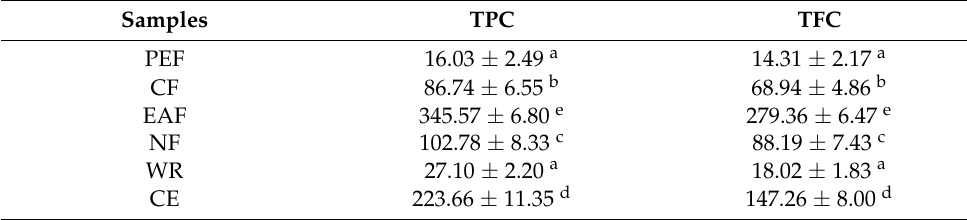
Table 1. The TPC and TFC of quinoa